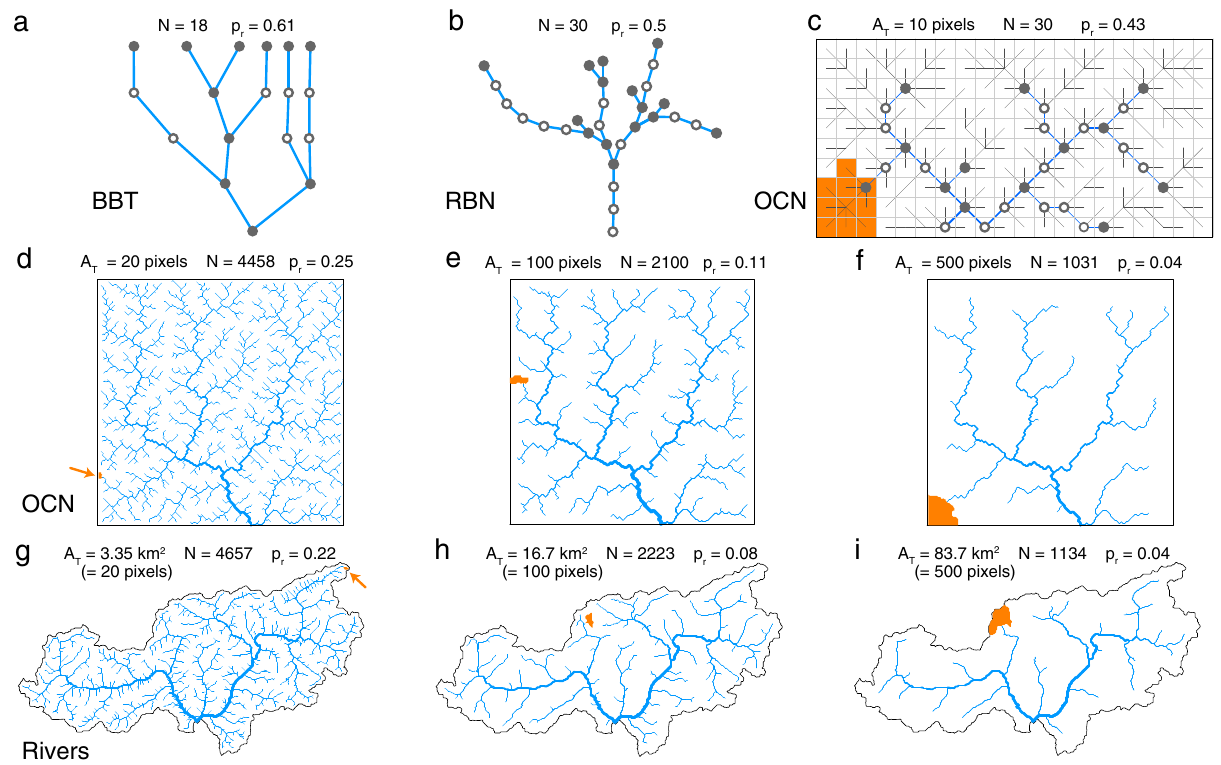
Fig. 1 Examples of networks analyzed as river analogues. a a BBT network 45 . b a RBN network 46 . c A small OCN built on a 20 × 10 lattice and extracted with A T = 10 pixels. The river network is depicted in blue, while fl ow directions in the regions where A T < 10 pixels are drawn in grey. d – f An OCN built on a 200 × 200 lattice and extracted with three different values of A T . g – i A real river (Adige, Italy) extracted from a DEM (with pixel size l = 409.25 m) with three different values of A T ; the catchment spans an area of 40,608 pixels. Network nodes are marked with grey dots in panels a , b and c (with fi lled dots corresponding to “ branching" nodes, i.e. identifying the start of a link); the black solid lines in panels c – i depict the extent of the areas drained by the river networks. Orange areas (highlighted by arrows in panels d , g ) depict the extent of the area (equal to A T ) drained by an arbitrary